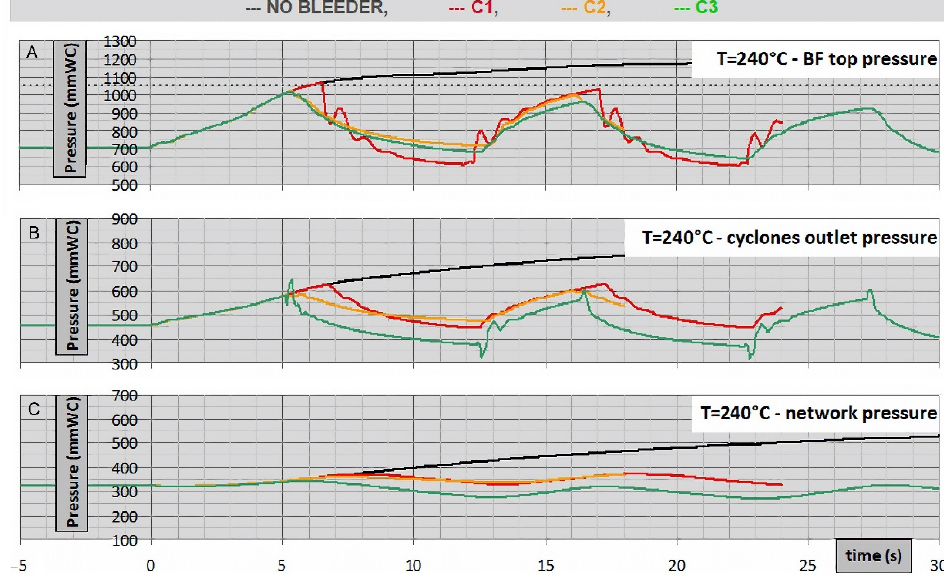
Figure 12. Evolution over time of pressure in the three different circuits C1, C2 and C3 compared with the no bleeders case in a medium severity event. ( A ) BF top pressure; ( B ) cyclones outlet pressure; ( C ) network pressure.